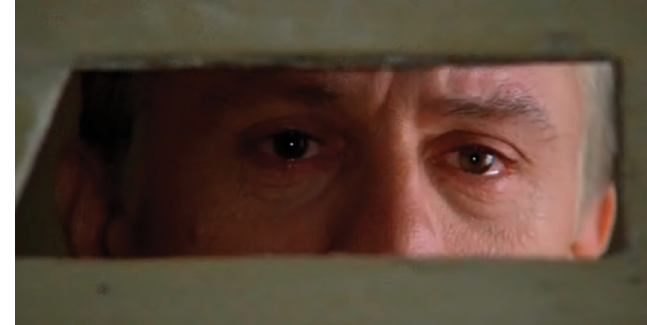
Figure 3 – Still from Cinema (2018), by Rodrigo Areias